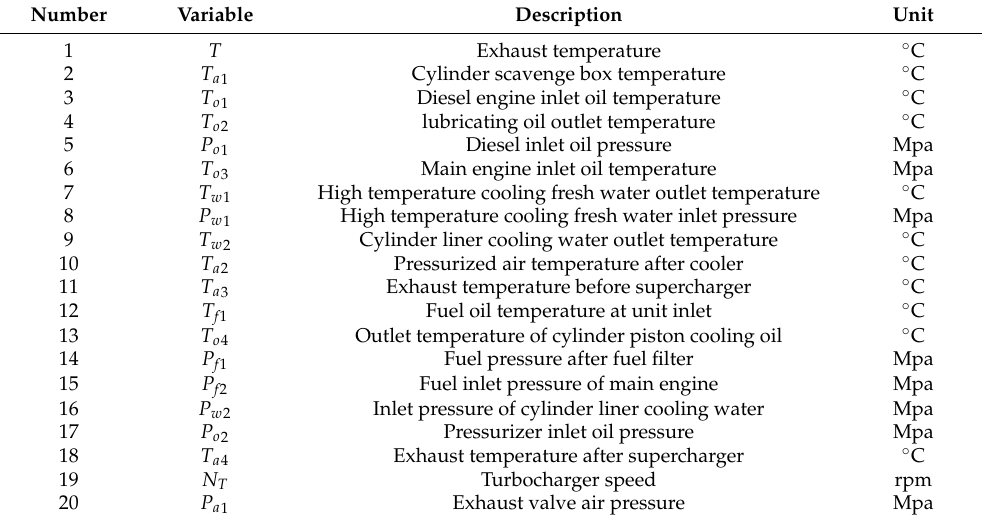
Table 2. Initial Variables.